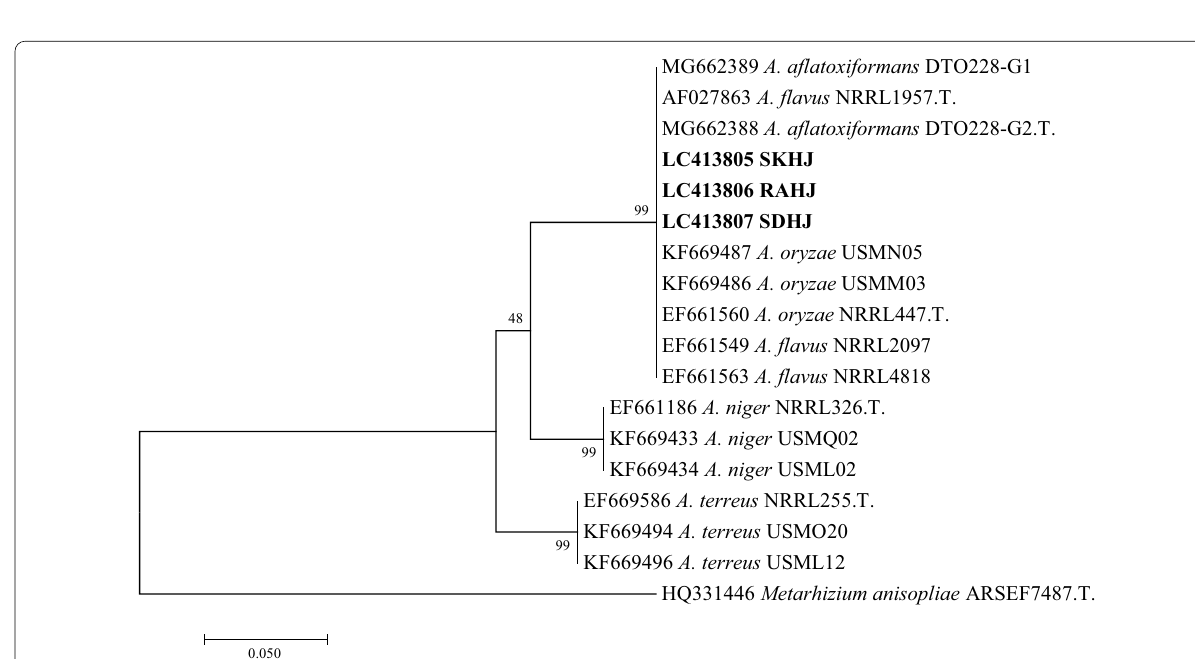
Fig. 4 Phylogenetic tree developed based on sequence analysis of ITS region by primer ITS1 and ITS4 with Maximum Likelihood method (Tamura–Nei model) created using MEGA7 for windows (Kumar et al. 2016). Isolate of SKHJ, SDHJ and RAHJ placed within group of ex type isolate and reference strains of Aspergillus oryzae (NRRL447.T., Acc. EF661560; USMN03, Acc. No. KF669486; USMN05, Acc. No. KF669487) , A. flavus (NRRL1957.T., Acc. No. AF027863; NRRL2097, Acc. No. EF661549; NRRL4818, Acc. No. EF661563) and A. aflatoxiformans (DTO228-G2.T., Acc.